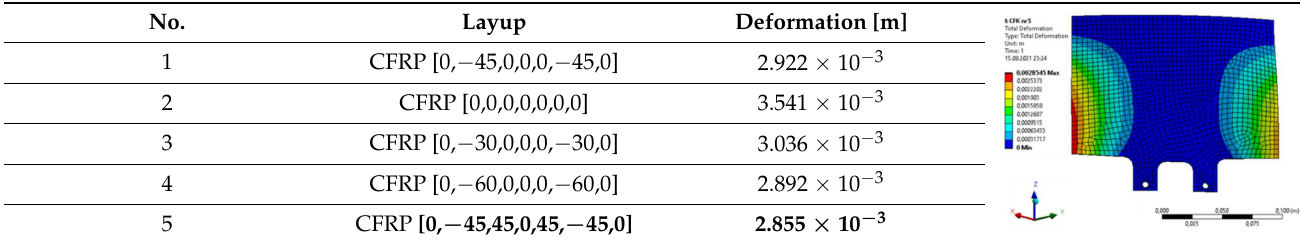
Table 5. FE simulation: CFK